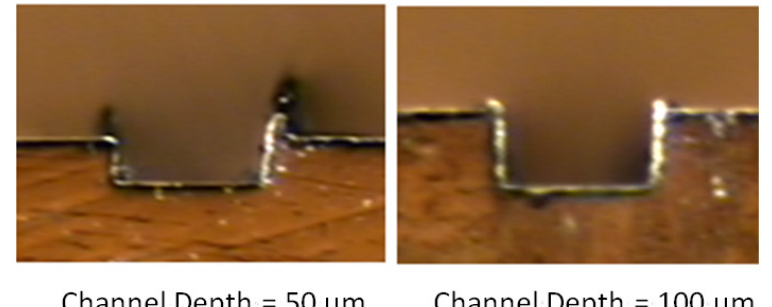
Figure 18. Channel depth influence on the shape